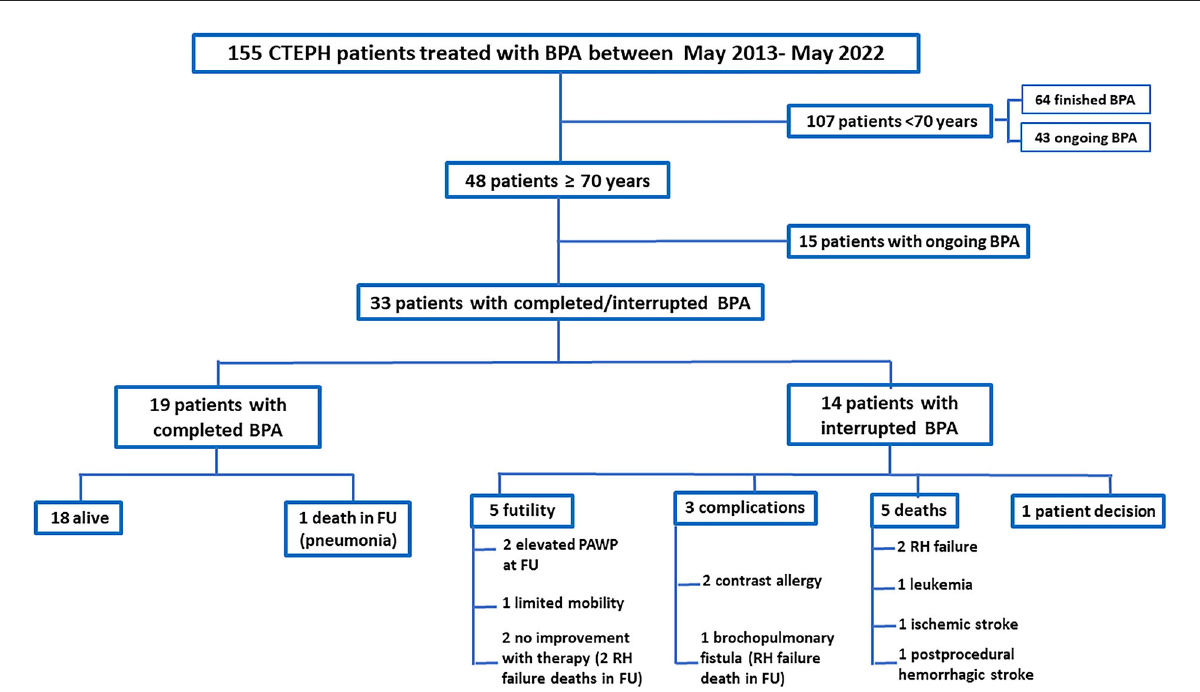
FIGURE4 Patient flowchart. BPA, balloon pulmonary angioplasty; CTEPH, chronic thromboembolic pulmonary hypertension; FU, follow-up; PAWP, pulmonary artery wedge pressure; RH, right